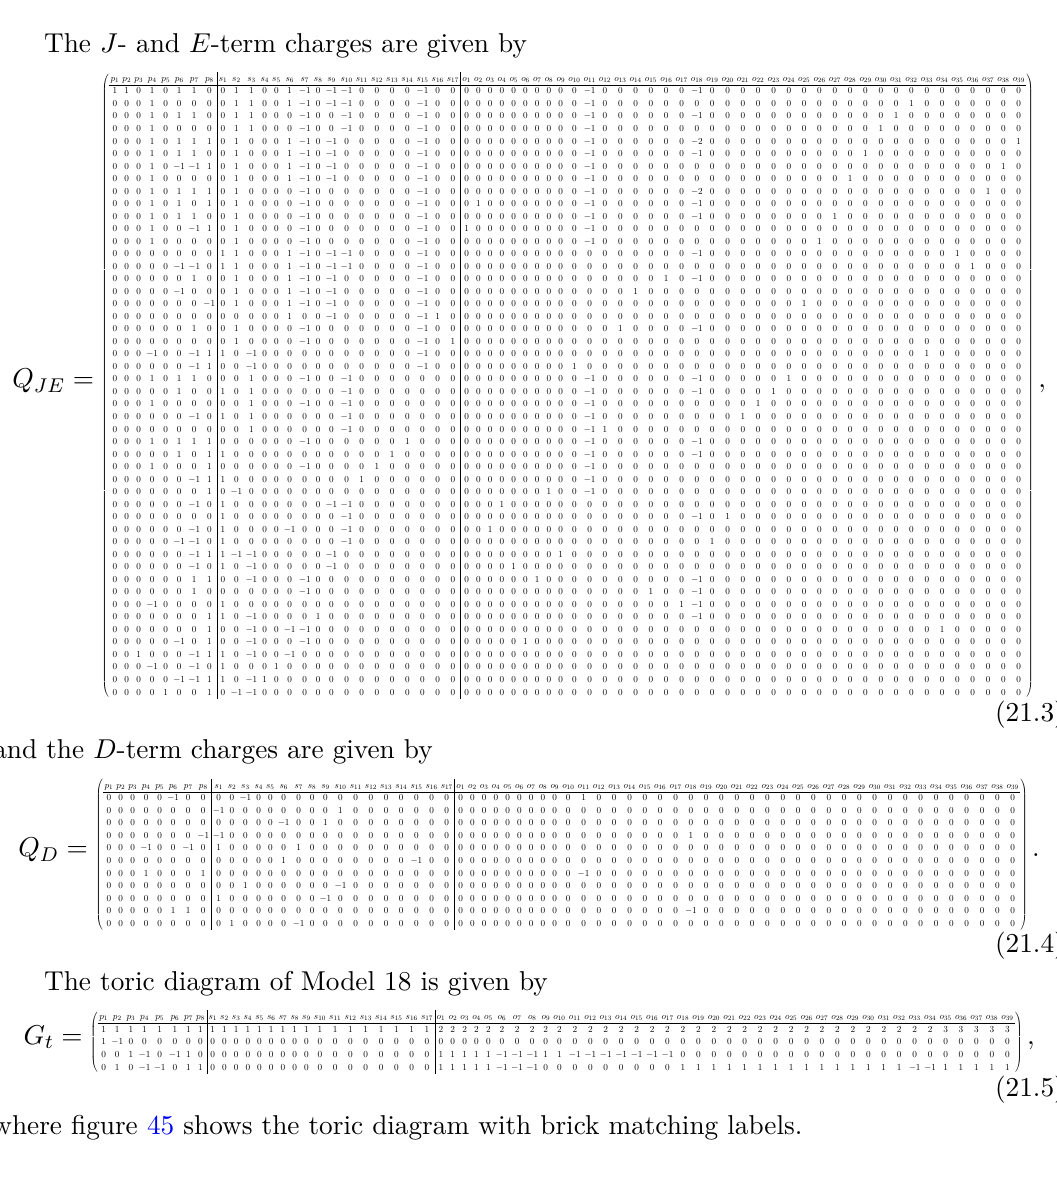
Figure 44 . Quiver for Model